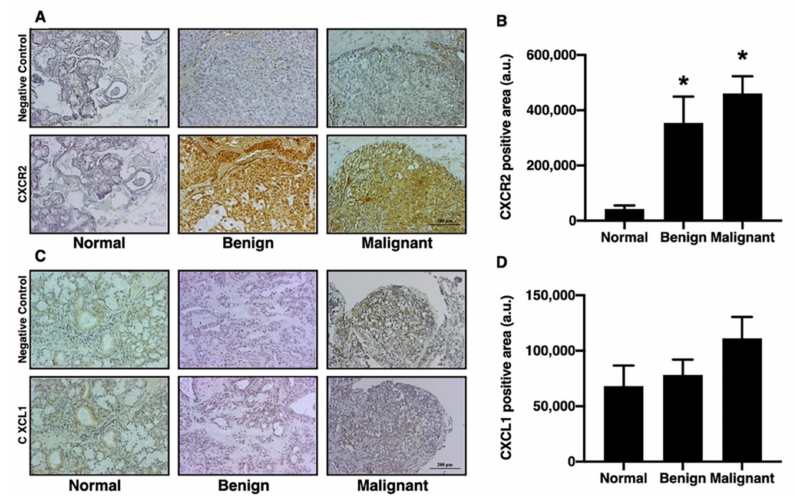
Figure 4. The CD44s and CD44v6 expression in oral salivary gland tumors. ( A ) The example images of CXCR2 positive area as indicated by IHC staining in normal, benign, and malignant groups (left to right panel, respectively) (bar = 200 µ m). ( B ) Benign group and malignant group increased CXCR2 positive. ( C ) The example images of the CXCL1 positive area as indicated by IHC staining in normal, benign, and malignant groups (left to right panel, respectively) (bar = 200 µ m). ( D ) CXCL1 positive area was no change among all groups. * p < 0.05 vs. Normal.